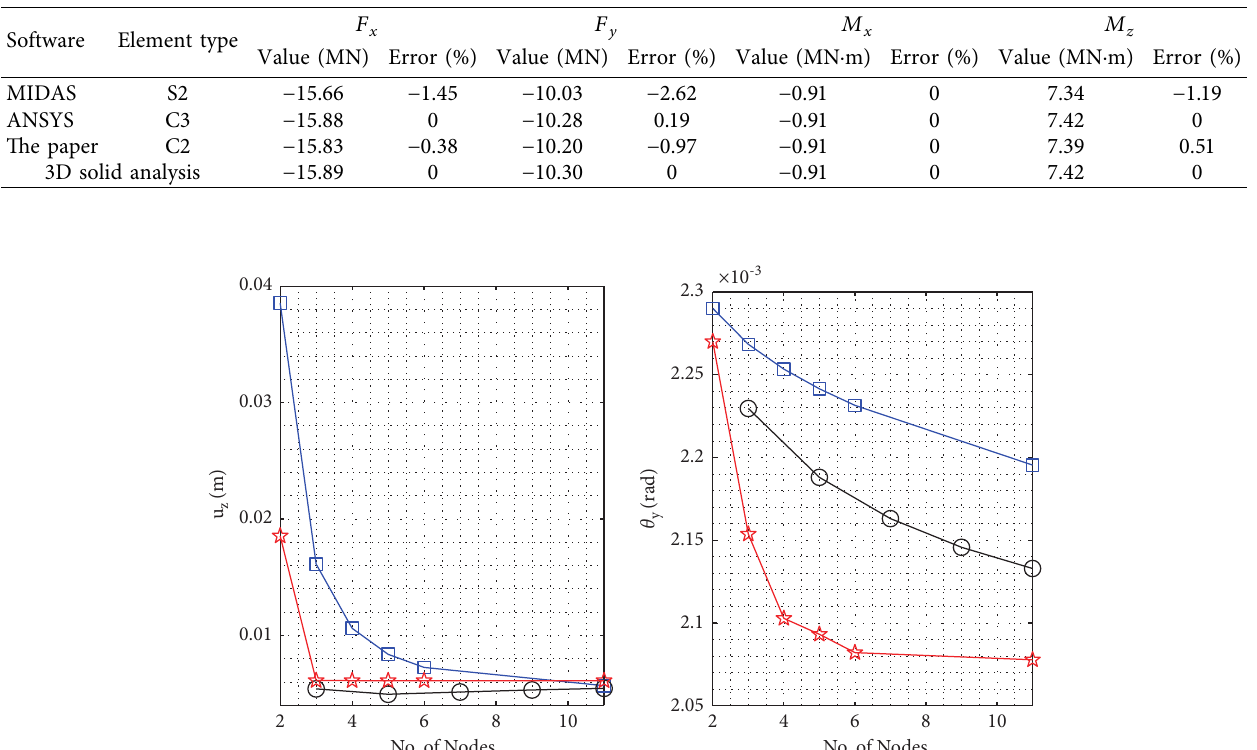
Table 3: The maximum stress resultants and couples of the quarter arc beam.